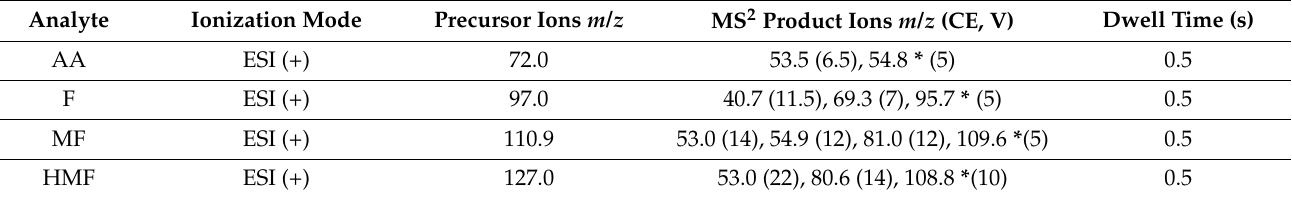
Table 1. Mass spectrum parameters for acrylamide (AA), furfural (F), 5-methylfurfural (MF) and hydroxy-methyl-furfural (HMF) using the developed HPLC-QqQ-MS/MS method.